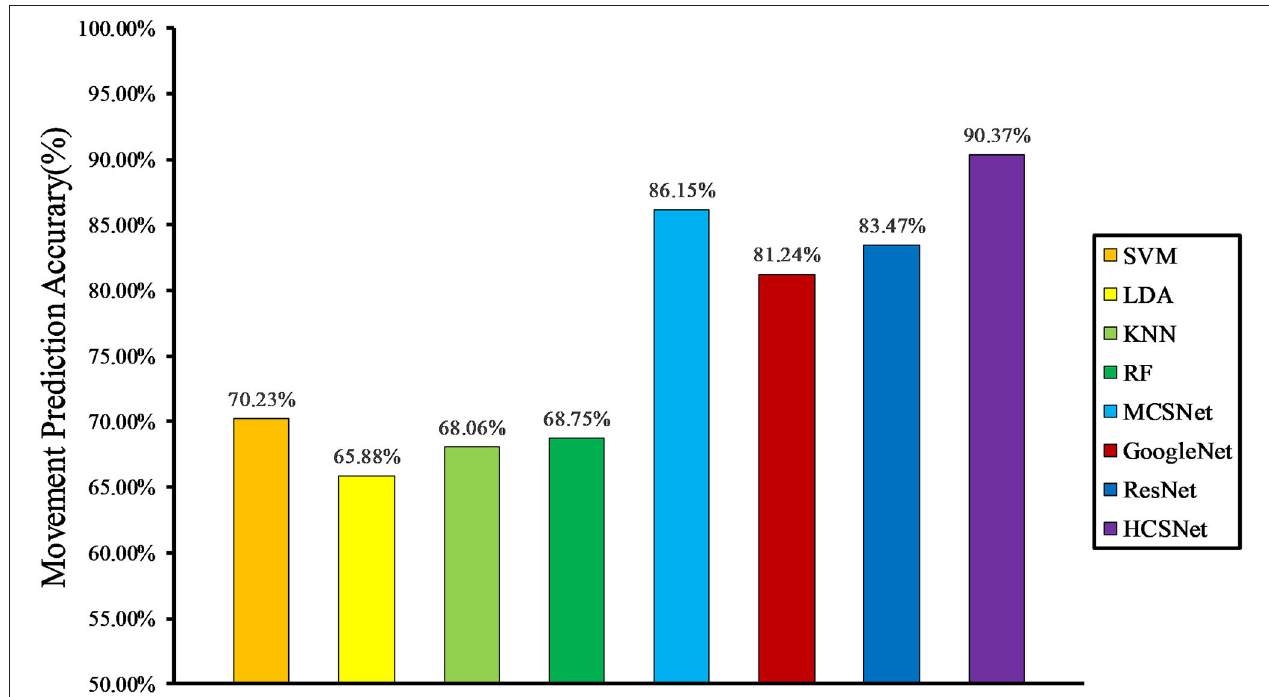
FIGURE 6 | Cross-subject movement prediction performance averaged over all